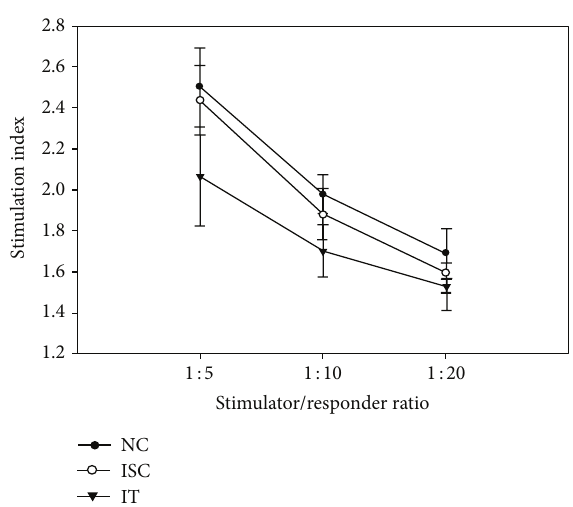
Figure 3: Effect of dendritic cells’ stimulation on proliferation of T lymphocytes in mixed lymphocytes reaction.